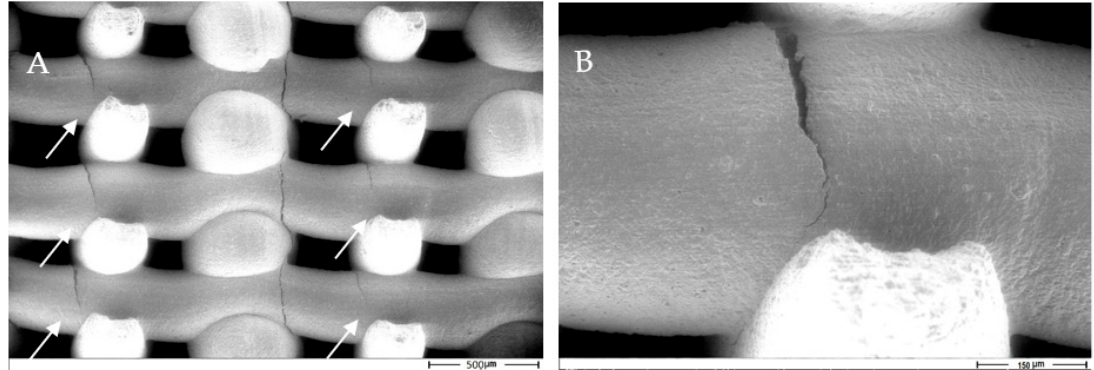
Figure 10. (A) Longitudinal cracks running through the structure of a porous scaffold during the compression test observed by ESEM, (B) a higher magnification image of a representative of the cracks.